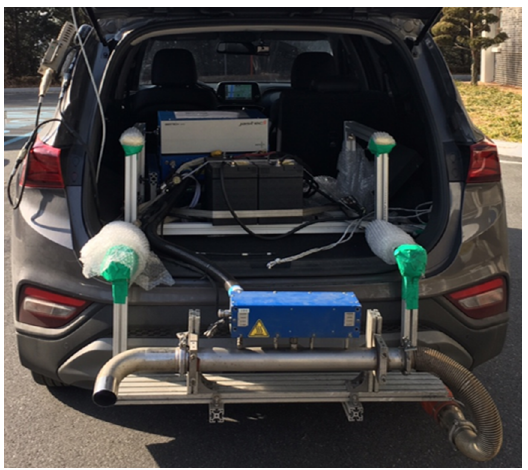
Figure 1. Example of the PEMS equipment installed on the test vehicle.